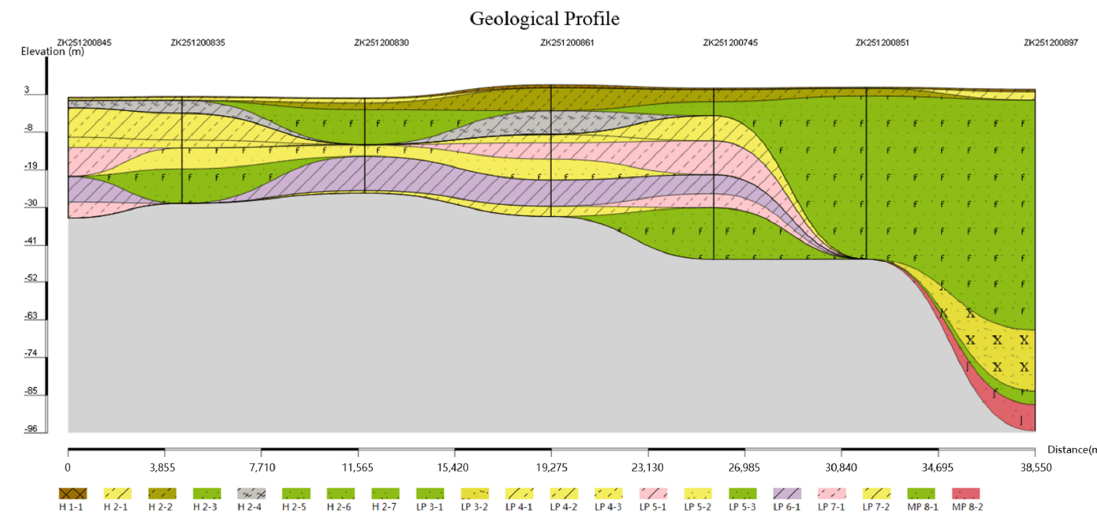
Figure 14. Geological profile VII corresponding to drilling line VII in Figure 12 by unique path method.